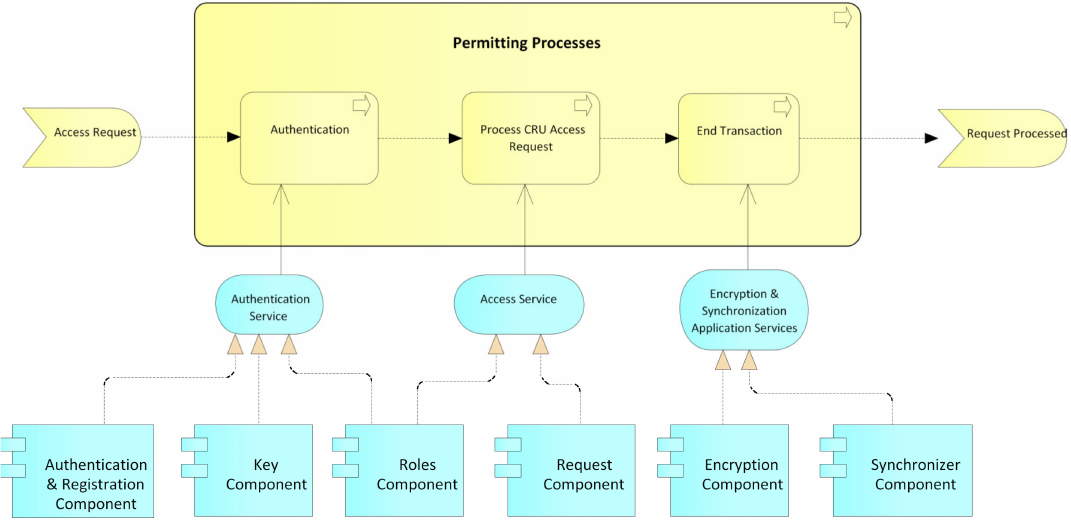
Figure 11. Permitting